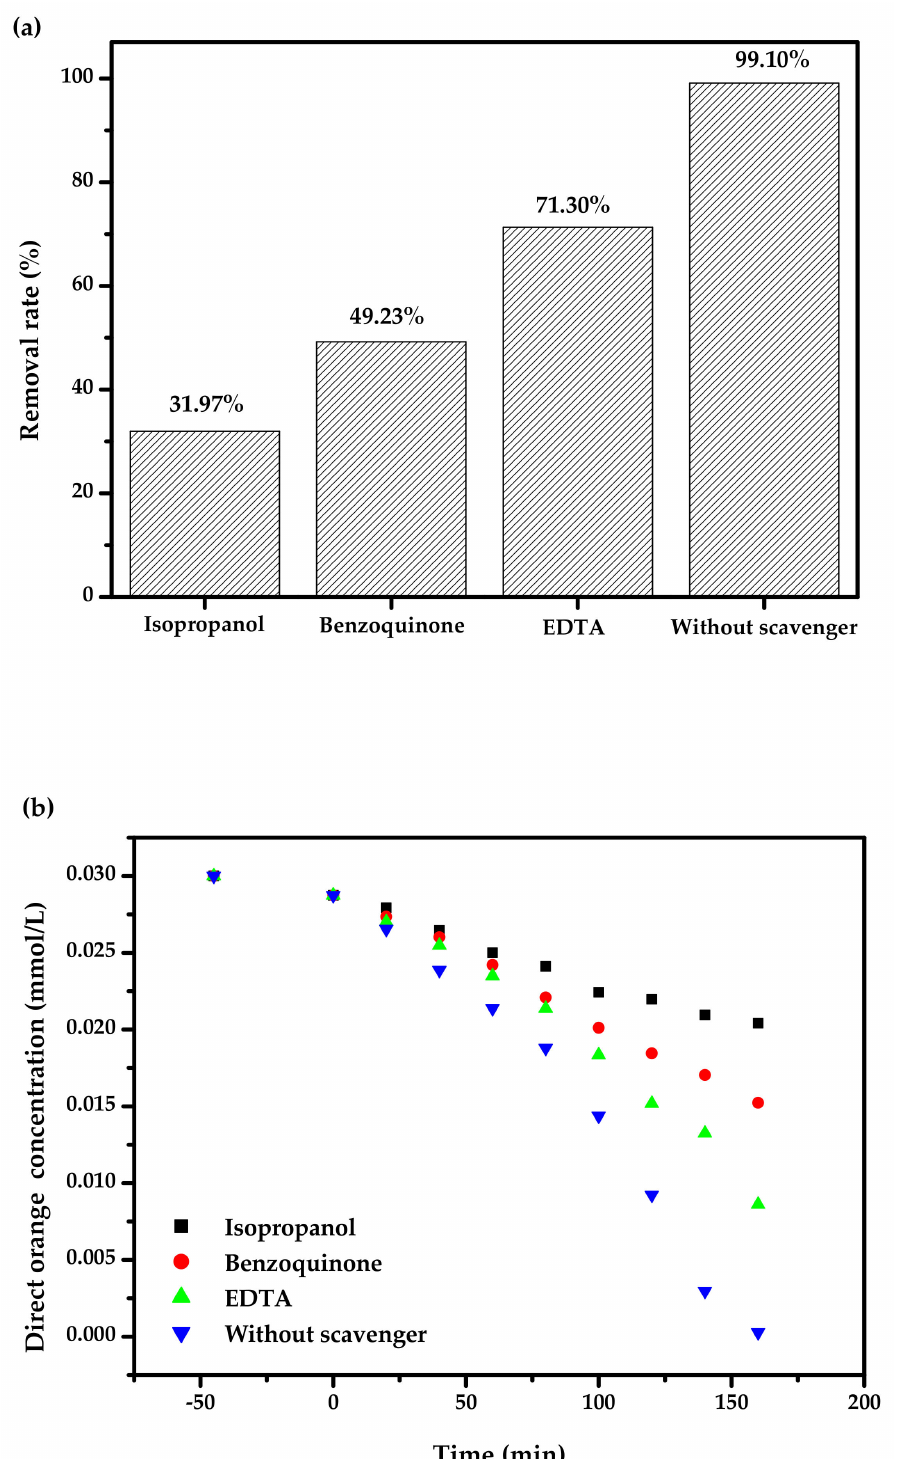
Figure 19. ( a ) RR of DO by using three trapping agents with BZH as the catalyst under VLI. ( b ) The relation curves among ethylenediamine tetraacetic acid (EDTA), isopropanol (IPA) or benzoquinone (BQ) and RR of DO with BZH as the catalyst under